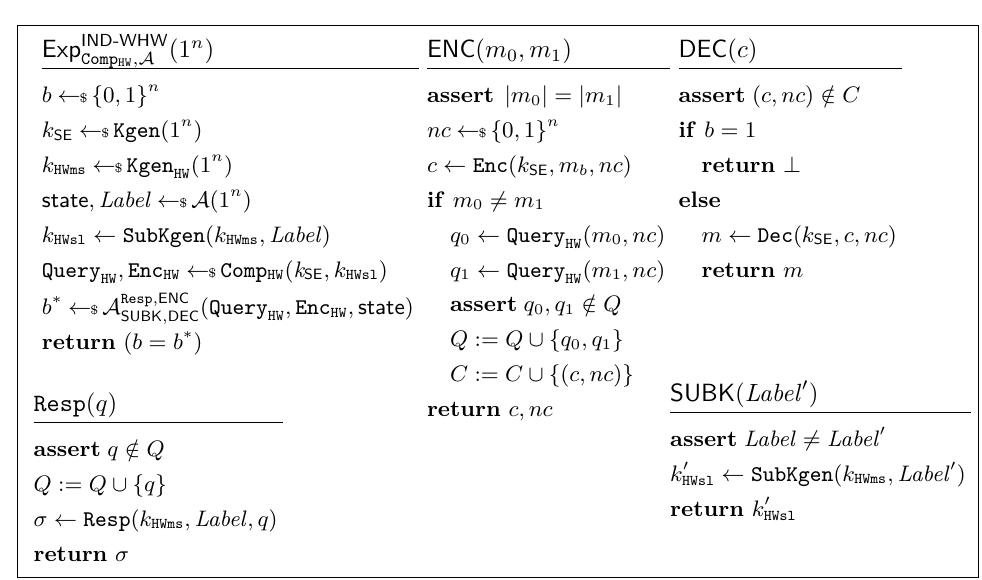
Figure 2: The Exp IND - WHW